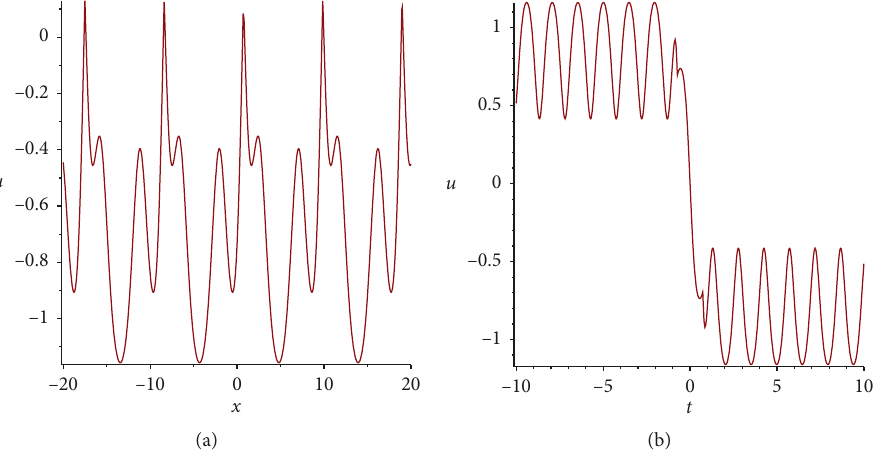
Figure 3: The interaction solution (39) with equations (51) and (52) and the parameters are fixed by (54): (a) the two-dimensional plot with t 1/2; (b) the two-dimensional plot with x (cid:29)